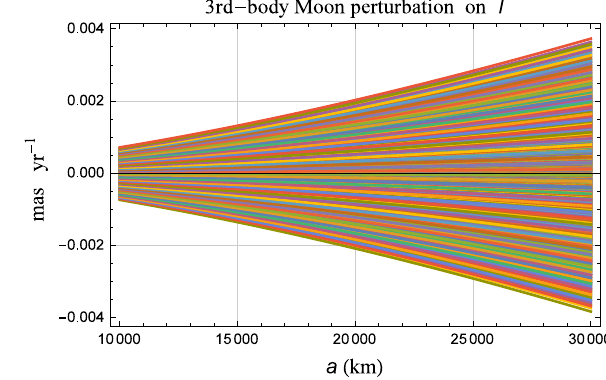
their natural range of variation 18 ◦ (cid:3) I (cid:2) (cid:3) 29 ◦ , − 14 ◦ (cid:3) (cid:2) (cid:2) (cid:3) 14 ◦ [57]. A relative error of 3 × 10 − 8 in the selenocentric gravitational constant μ (cid:2) was adopted